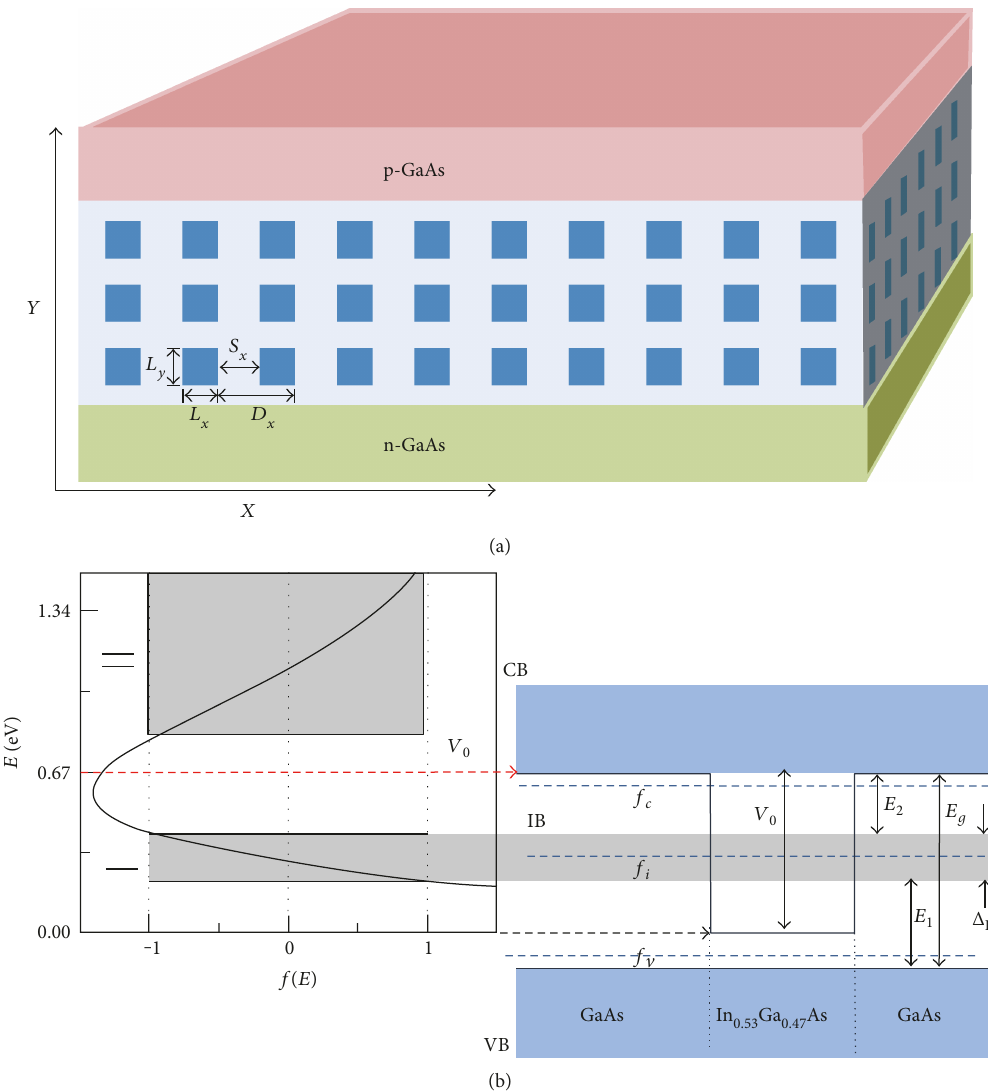
Figure 1: (a) Schematic structure and (b) miniband dispersion along with energy band diagram of In intermediate band solar